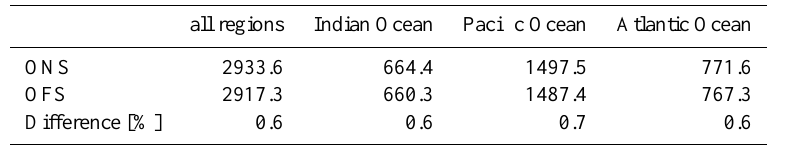
Table 2. Annual sea-salt emission amounts (Tgyr − 1 ) of the OFS versus ONS for the entire world, the Indian Ocean (19.7 ◦ E–115.3 ◦ E), the Pacific Ocean (115.3 ◦ E–70.3 ◦ W), and the Atlantic Ocean (70.3 ◦ W–19.7 ◦ E).